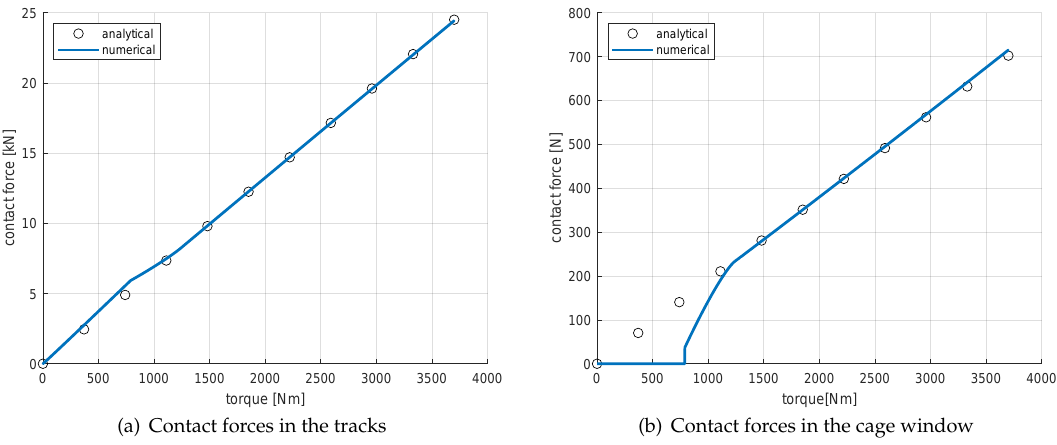
Figure 8. Verification of the contact forces by analytical results.